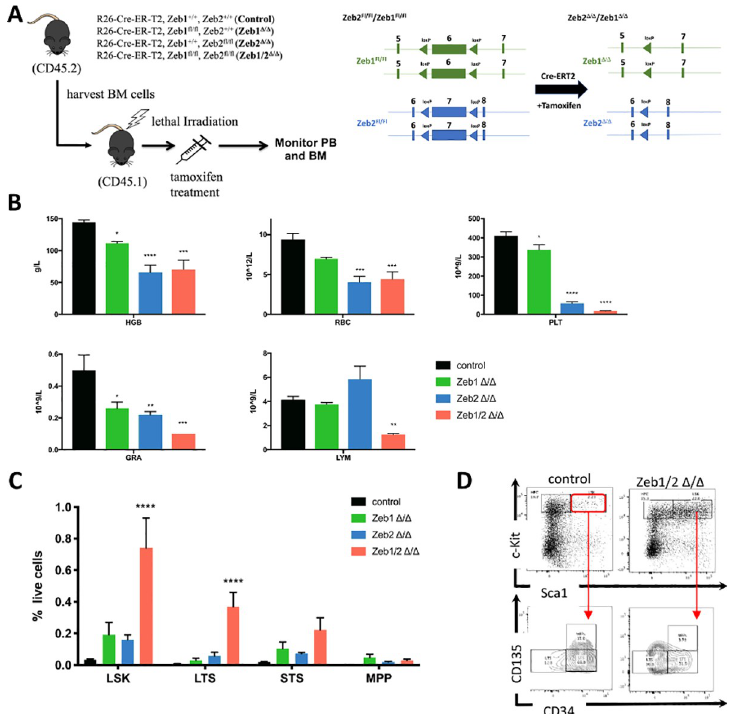
Fig 4. Double deletion of Zeb1 and Zeb2 causes PB cytopenia and severe differentiation defects in HSPCs. (A) Schematic of experiments (left panel) used to study the effect of tamoxifen-inducible deletion of Zeb1 , Zeb2 , or both after donor BM reconstitution (CD45.2 + ) of lethally irradiated recipients (CD45.1 + ). Schematic of lox P flanked (floxed- Fl) conditional Zeb1 and Zeb2 alleles before tamoxifen induced Cre-mediated deletion and recombined delta Zeb1 and Zeb2 alleles after recombination (right panel). (B) HCT analysis of BM 10 days after tamoxifen treatment showing decreased HGB (top left) in Zeb1 Δ / Δ , Zeb2 Δ / Δ , and Zeb1/2 Δ / Δ DKO settings. There was as well decreased RBC (top middle), PLT (top right), and GRA (bottom left). LYM (bottom middle) in the BM were decreased only in the Zeb1/2 Δ / Δ DKO. (C) Flow cytometric analysis of HSPCs in the BM 10 days after tamoxifen treatment showing increased numbers of LSK cells and well as LT-HSCs (LTS- lin − cKit + Sca1 + CD34 − Cd125 − ) in Zeb1/2 Δ / Δ DKO settings. (D) Representative flow cytometry analysis for hematopoietic stem and progenitor populations showing increased numbers of LSK and LT-HSCs in Zeb1/2 Δ / Δ DKO settings. Bars in panels represent mean ± SD, n = 5 per group; � p < 0.05; �� p < 0.01; ���� p < 0.0001, Dunnett multiple comparisons test. Raw data behind graphs are included in C of S1 Data. BM, bone marrow; DKO, double knockout; GRA, granulocyte; HCT, hematocrit; HGB, hemoglobin; HSPC, hematopoietic stem and progenitor cell; LSK, Lin − Sca1 + cKit + ; LT-HSC, long-term HSC; LTS, long-term HSC; LYM, lymphocyte; MPP, multipotent progenitor; PB, peripheral blood; PLT, platelet; RBC, red blood cell; STS, short-term